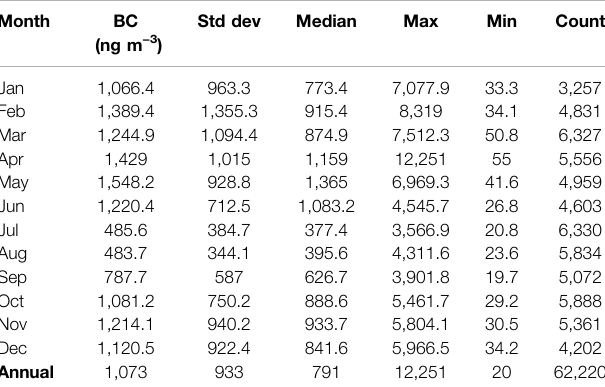
TABLE 1 | Average monthly BC during 2004 – 2016. The standard deviation, median, maximum, minimum, and total count are also